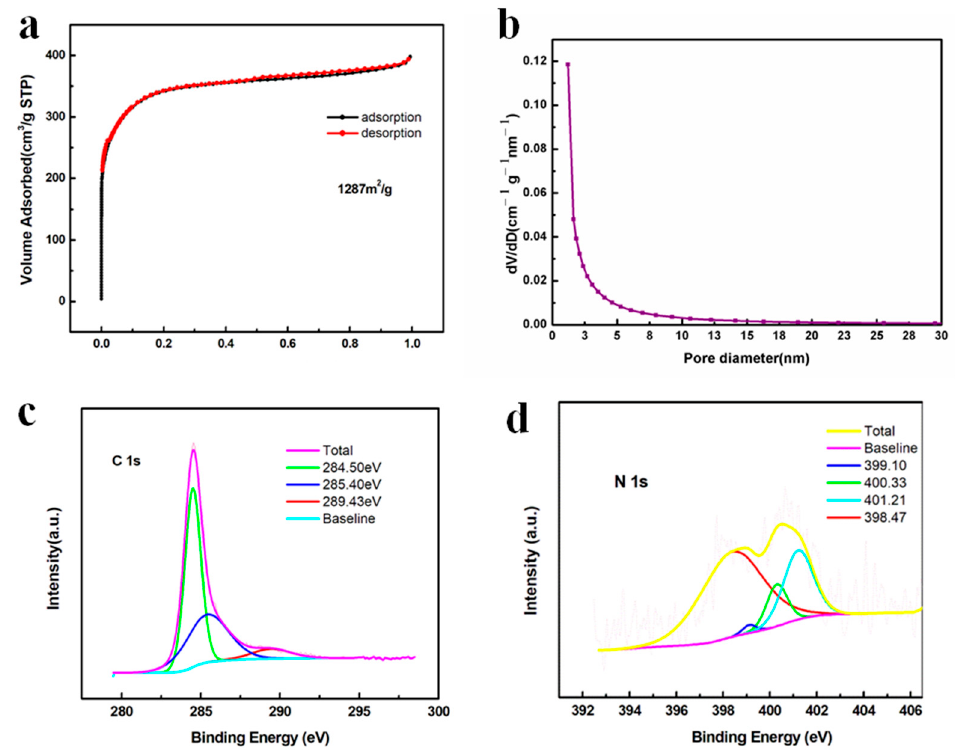
Figure 6. ( a ) N 2 gas sorption isotherm and ( b ) pore size distribution curve of Mn-N-C; XPS spectra of Mn-N-C ( c ) C 1s and ( d ) N 1s.